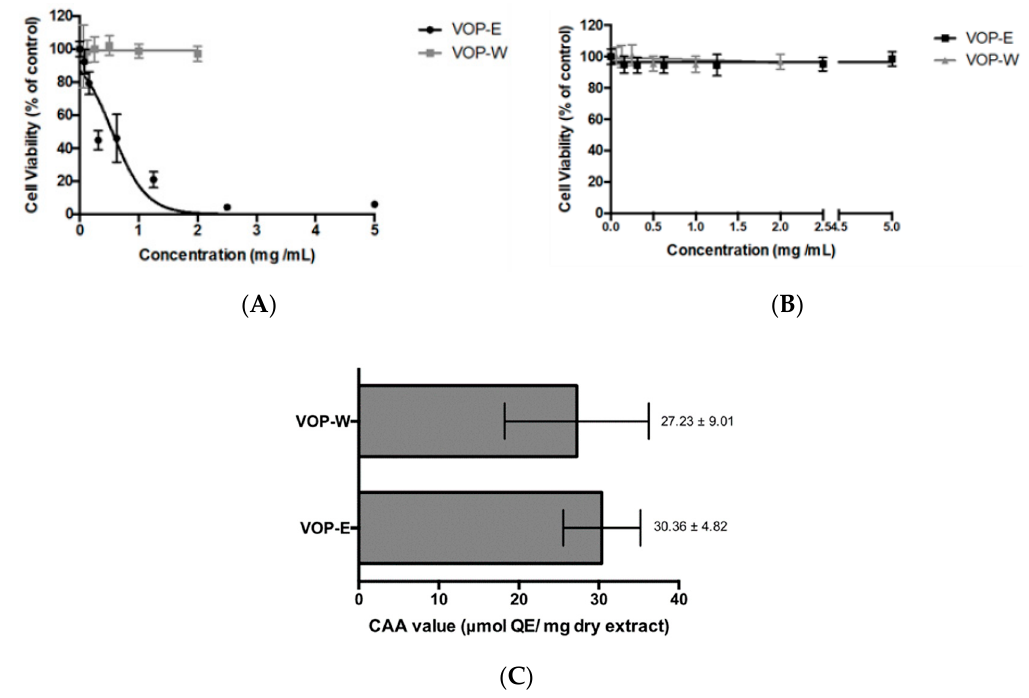
Figure 3. Dose–response curves of Viburnum opulus berry pomace (VOP) extracts. Antiproliferative ( A ) and cytotoxicity ( B ) effects using HT29 and Caco-2 cell lines, respectively. Results are expressed in terms of mean ± SD performed in triplicate. Antioxidant activity of VOP extracts evaluated by the cellular antioxidant activity (CAA) assay ( C ). Results are expressed as μ mol QE per mg of dry extract of mean ± SD performed in triplicate. Unpaired t test was assessed with p < 0.05.